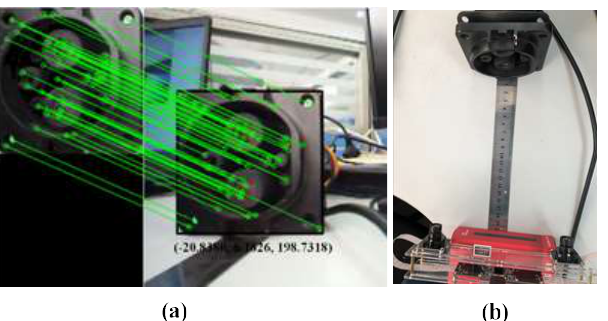
Figure 10. Comparison of two measurement results: ( a ) Identification and distance measurement of charging port; ( b ) scale measurement results. Table 3. Binocular camera range results (unit: mm) under (1st, …, 6th rows) random change in light in normal range and (7th row) an overexposure condition.